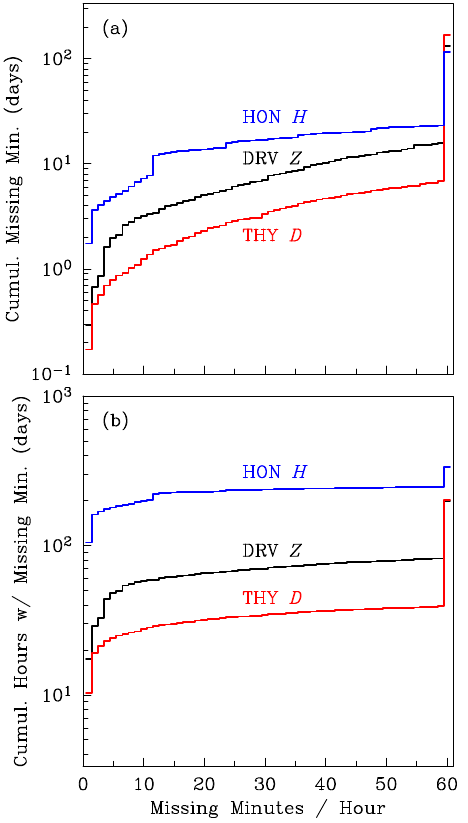
Fig. 3. Cumulative missing minutes (a) for (DRV Z , THY D , HON H ) and cumulative hours (b) with missing minutes, each as a func- tion of number of missing minutes per hour. The cumulative of the missing-minutes-per-hour density results shown in Fig.